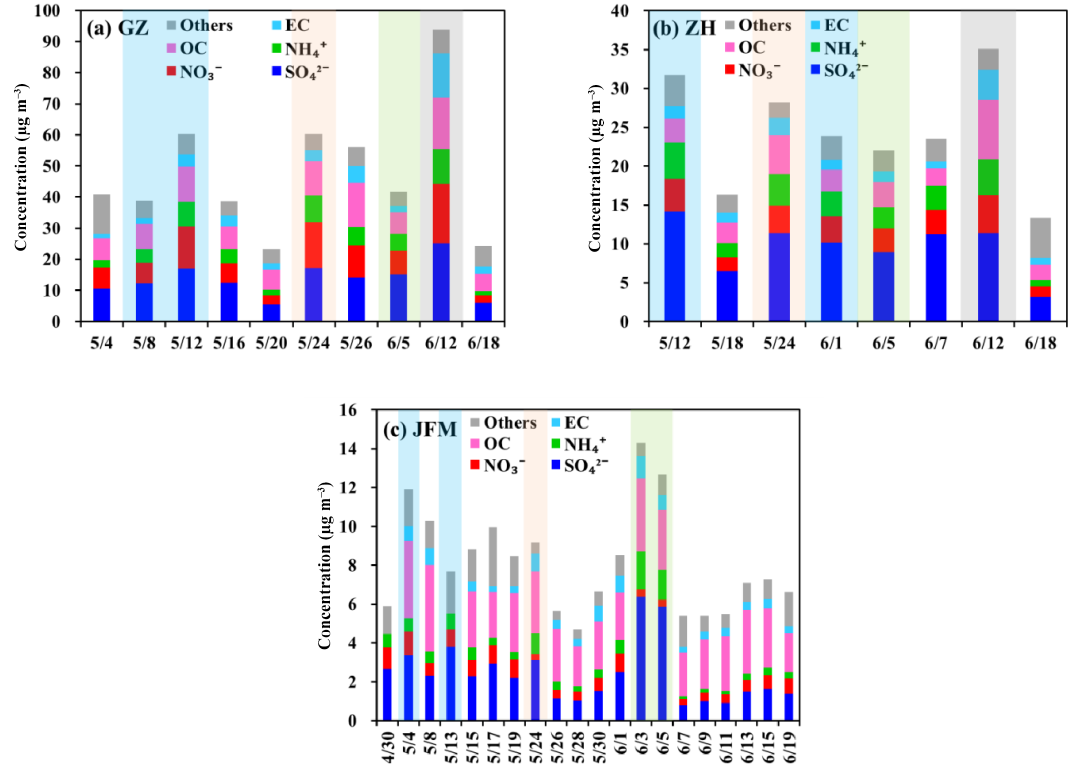
Figure 2. Time series of PM 18 chemical compositions at the three sites during the 2010 wet